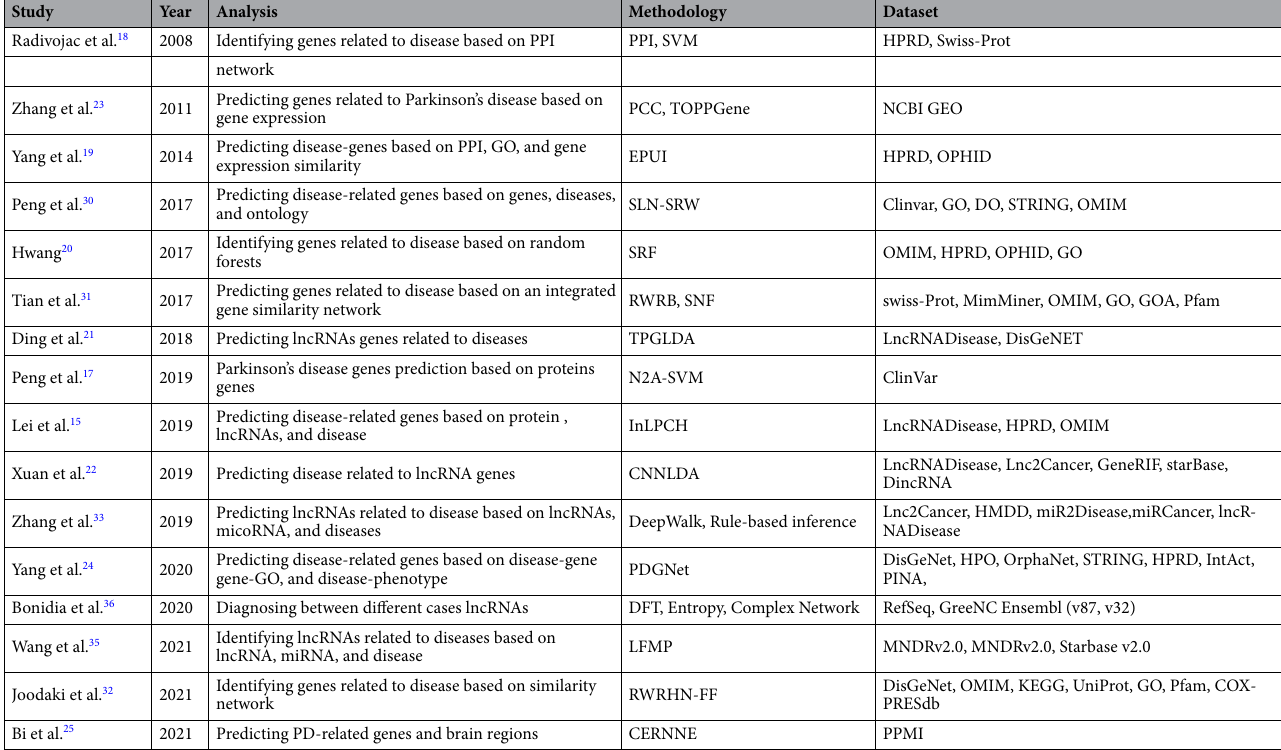
Table 2. A comparison of some recent